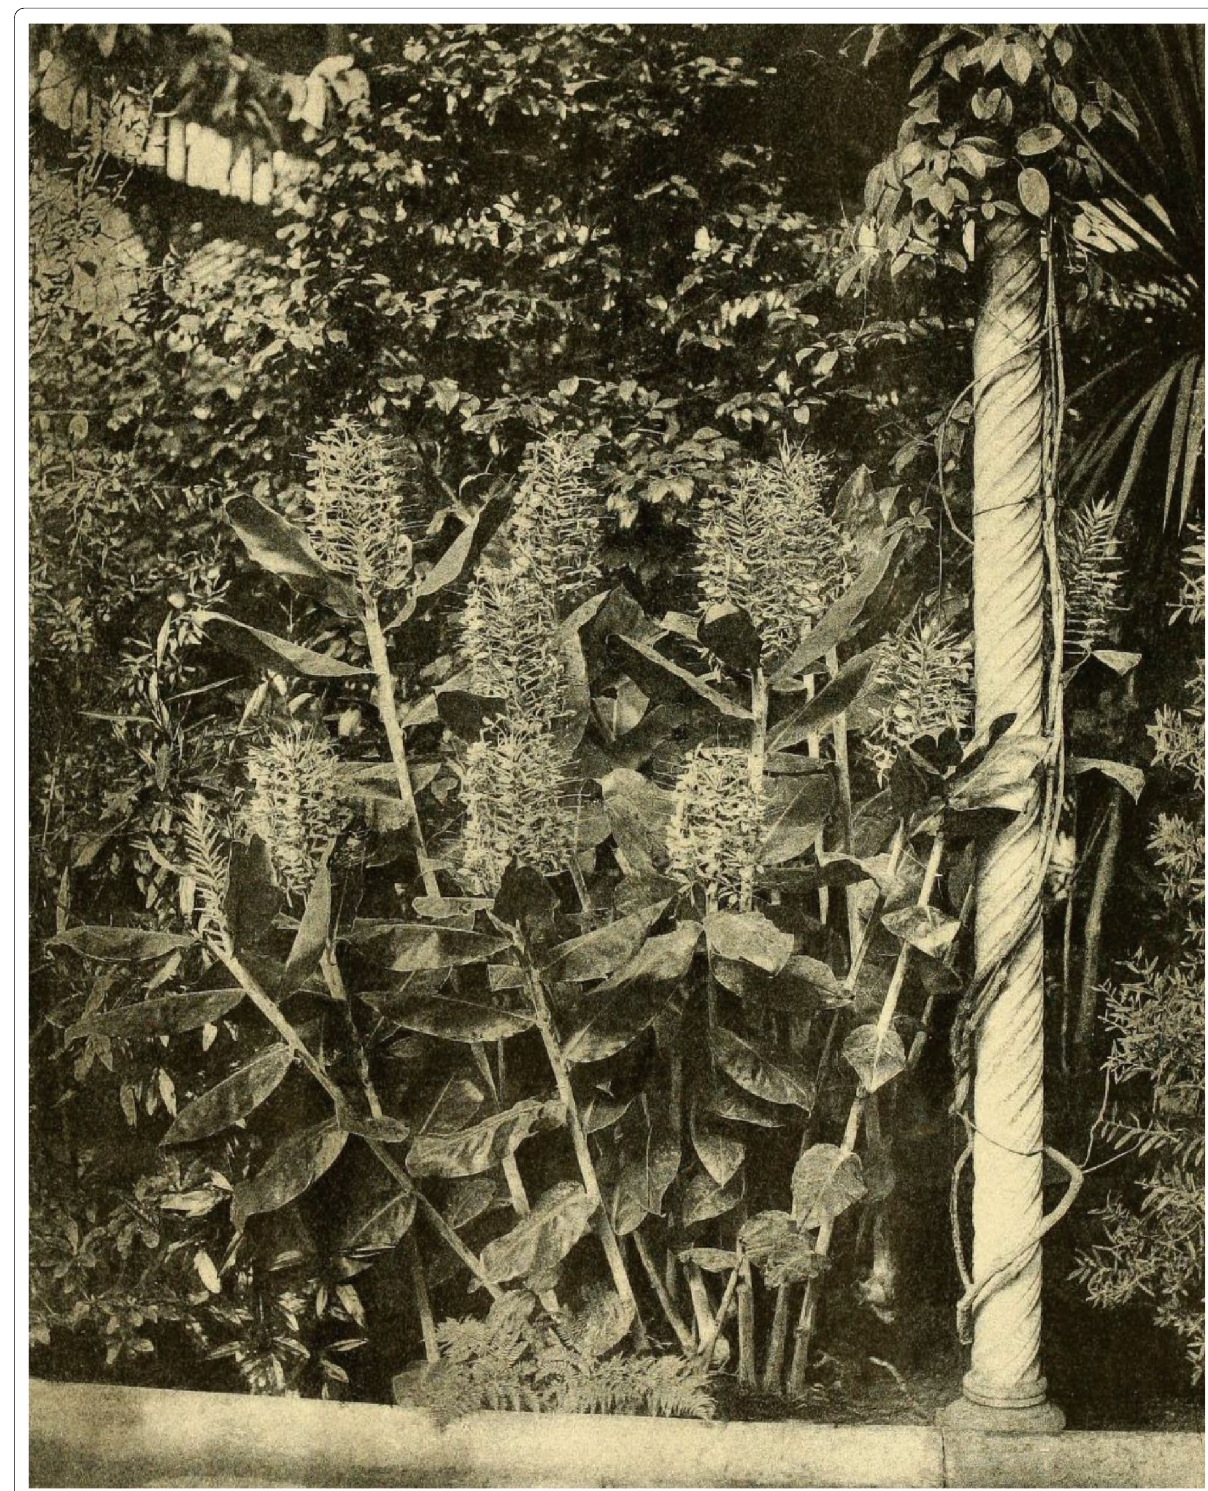
Fig. 5 Ink-photo (Sprague & Co.) of Hedychium gardnerianum flowering at Glasgow Botanic Garden in 1892; probably the first photo of the species (Gardeners’ Chronicle